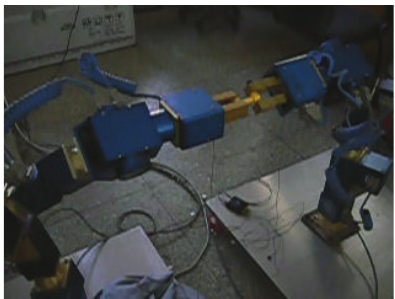
Figure 5: The bolt and nut assembly by cooperative modular